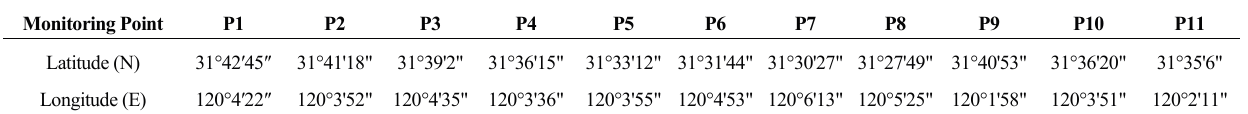
Table 1. The latitude and longitude of monitoring